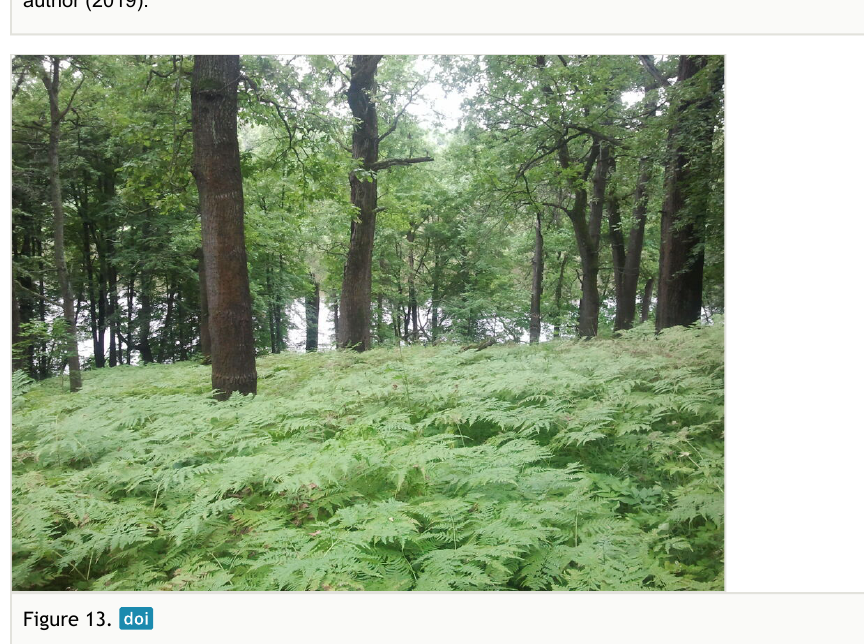
Figure 13. Typical plant communities of the Patakino local flora (Vladimir Oblast, Russia): broadleaved forest (Querco-Fagetea) dominated by Pteridium pinetorum C.N. Page & R.R. Mill. Photo by the author